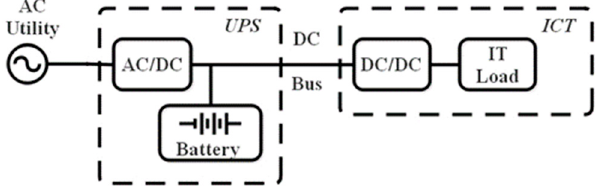
Figure 1. Diagram of conventional DC power distribution system in data centers.